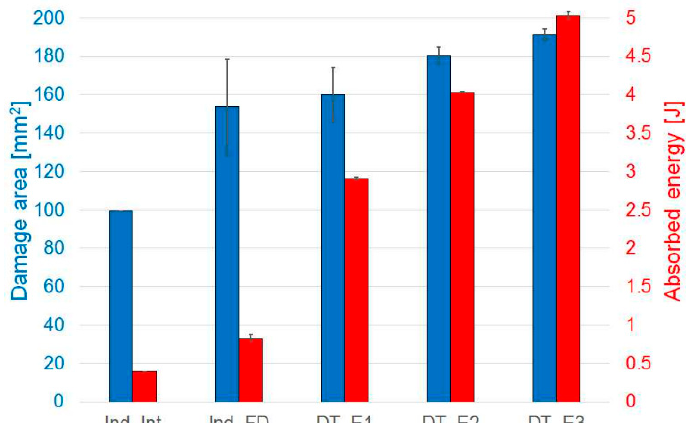
Figure 8. Indentation and impact tests: comparison of damage area and absorbed energy. Indented Interrupted (Ind_Int) and Indented Fully Damaged (Ind_FD) specimens and samples impacted respectively at 2.2 J (DT_E1), 3.2 J (DT_E2) and 4.2 J (DT_E3). Error bars represent standard deviation. Table 3. Stereo DIC set-up and the processing parameters. Characteristic Set-Up Technique used